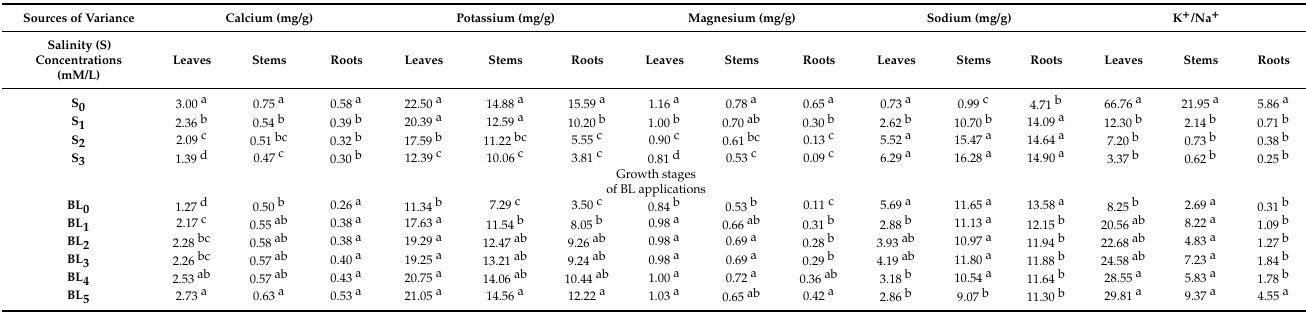
Table 2. Main effects of salinity (S) and brassinolide (BL) on calcium (Ca), potassium (K), magnesium (Mg), sodium (Na) and K + /Na + in leaves, stems and roots of soybean at